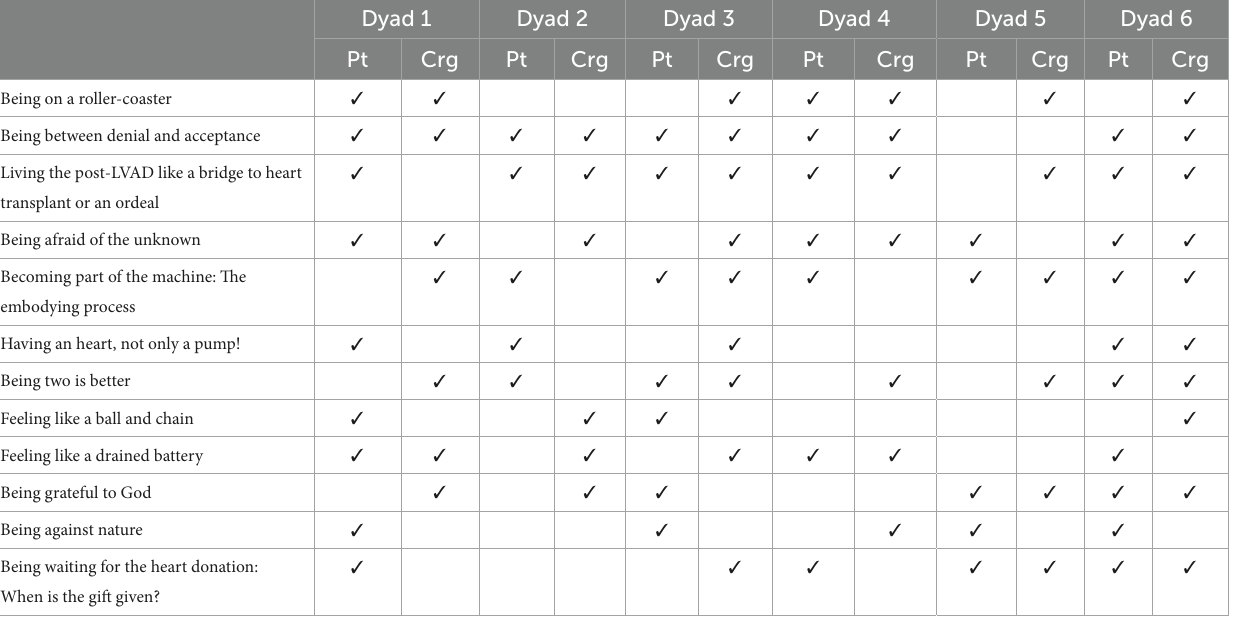
TABLE 3 Frequency of subthemes identified with